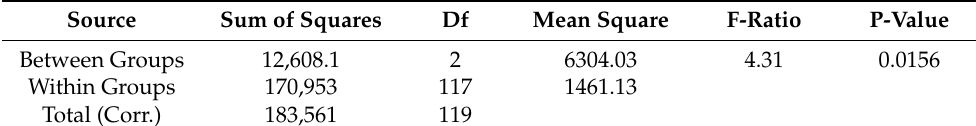
Table 3. ANOVA table for Col_4 Time-to-ignition by Col_2 thickness.